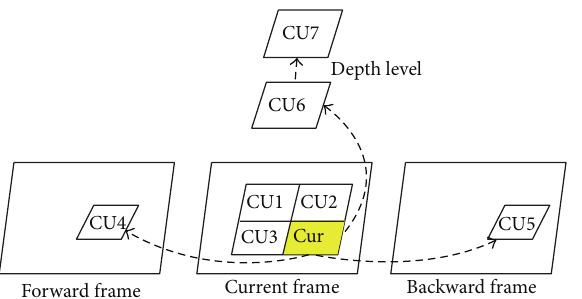
Figure 3: Relationship between the current and adjacent blocks.